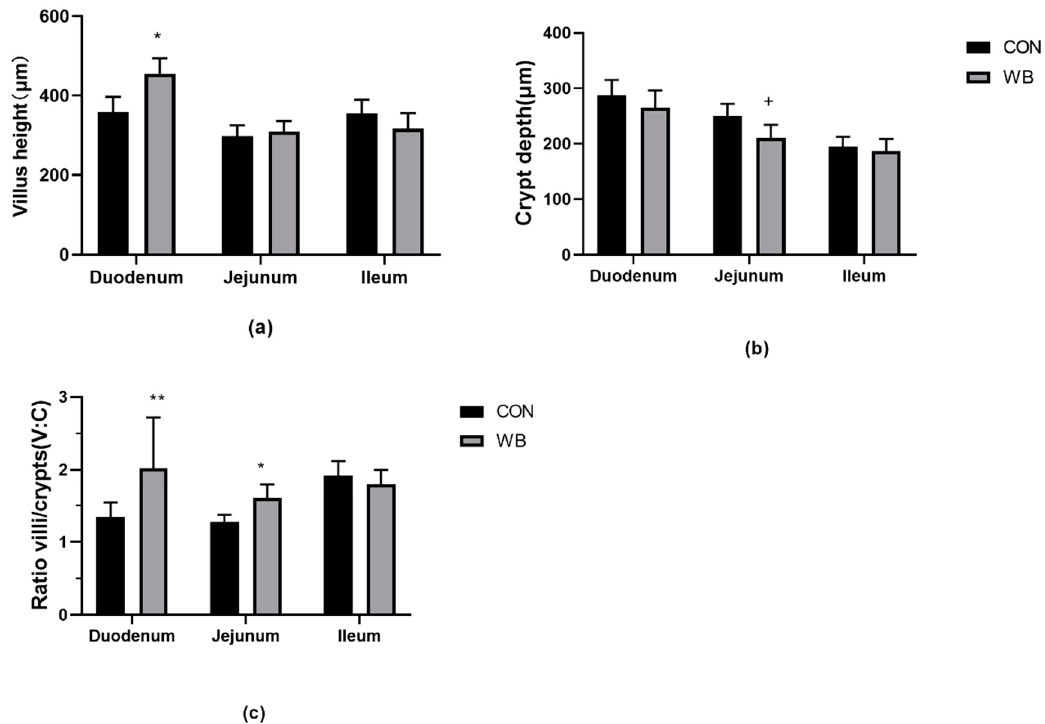
Figure 1. The villus height ( a ), crypt depth ( b ) and villi / crypt (V:C) ratio ( c ) of piglets born from CON (black bar) or WB (grey bars) sows, n = 8, values are shown as mean ± SEM, * means p < 0.05, ** represents p < 0.01 + represents p < 0.10, the unit of height and depth is μ m.